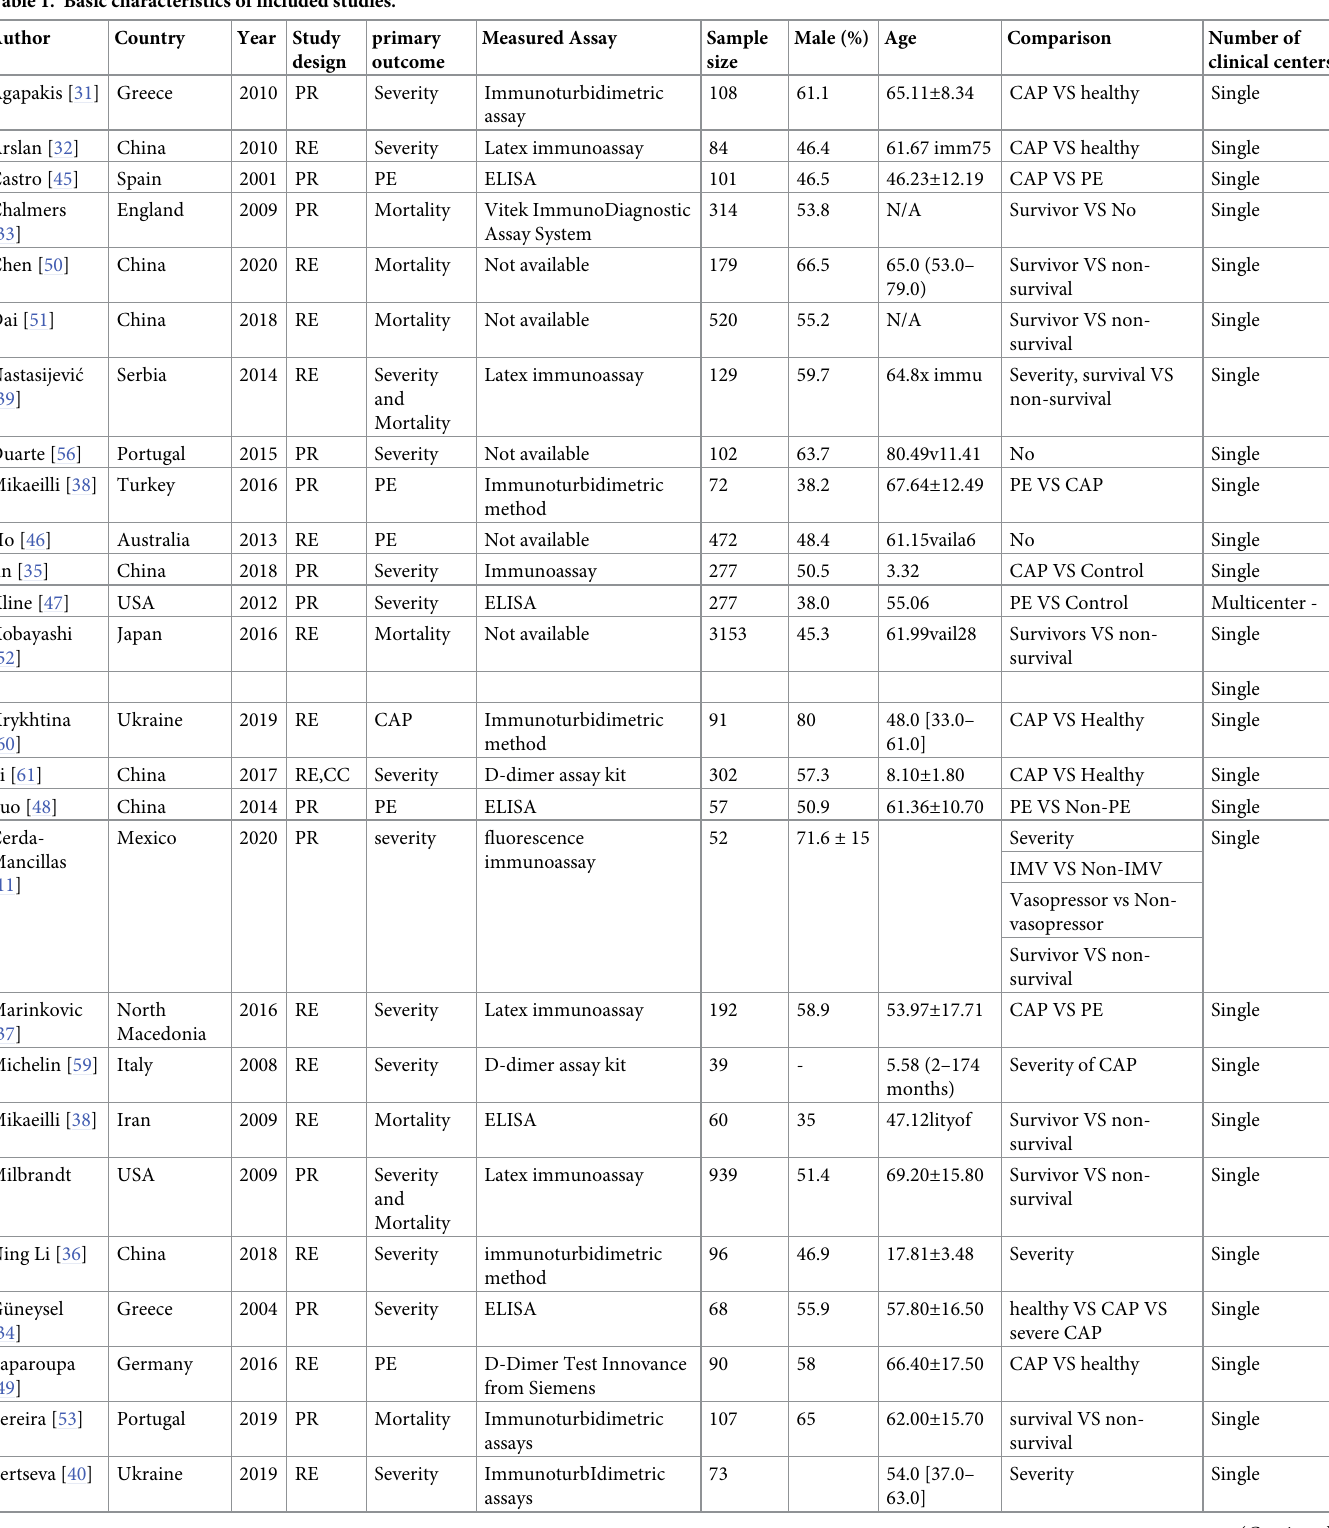
Table 1. Basic characteristics of included